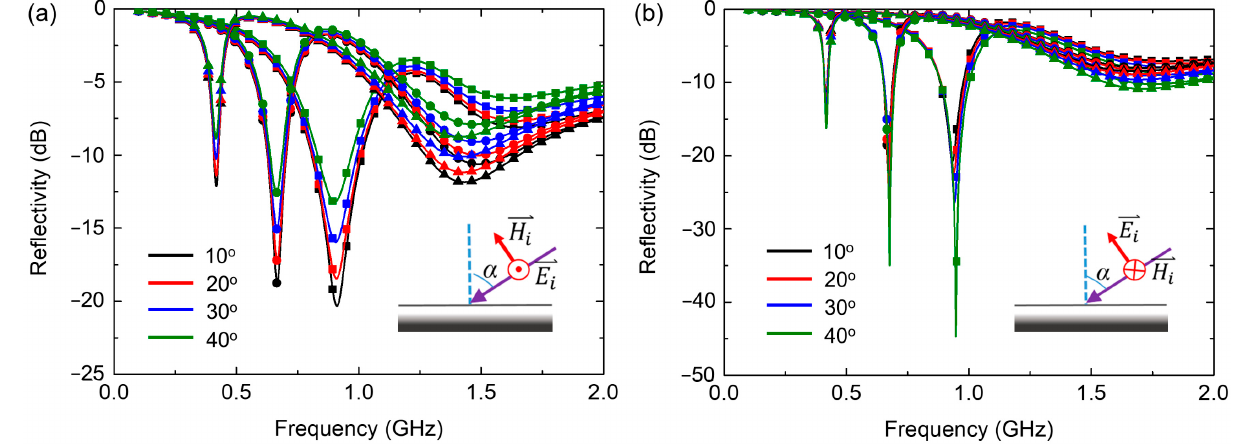
Figure 6. Simulated reflectivity of the absorber under y -polarization oblique incidence for ( a ) the TE mode and ( b ) the TM mode. The square, circle and up-triangle symbols represent that the varactor capacitance is 0.35 pF, 1.03 pF and 3.2 pF, respectively. Insets show the definition of TE and TM mode.